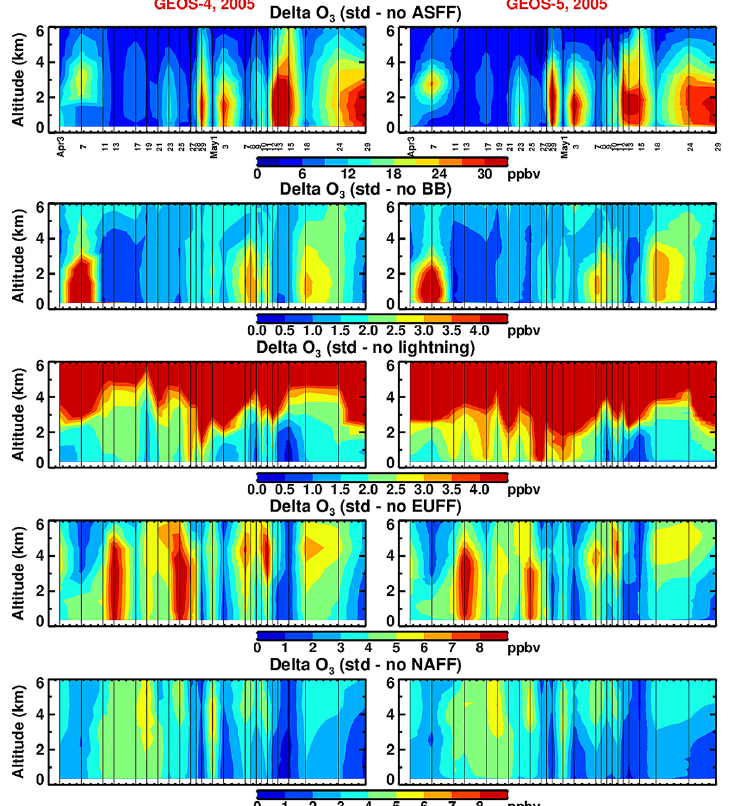
Figure 7. Decreases in the lower-tropospheric O 3 concentrations (ppbv), as simulated by GEOS-Chem driven by the GEOS-4 (left panels) and GEOS-5 (right panels) meteorological fields, when Asian, European, and North American fossil fuel emissions, and biomass burning emissions or lightning NO x emissions were suppressed, individually, relative to their standard simulations for April–May 2005. Note the different scales on color bars. Colors are saturated when values are out of range.